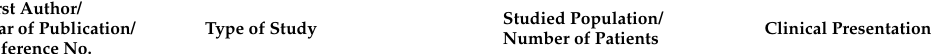
Table 1. Clinical spectrum of 3 β HSD2 deficiency: original studies published on PubMed within the last decade (the papers are listed starting with the most recent, from 2022 to 2012) (References: